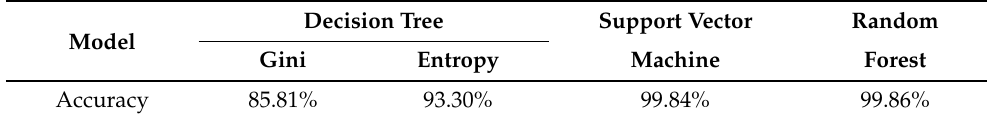
Table 3. An example to show the prediction accuracies of the three ML models. Decision Tree Support Vector Random Model Gini Entropy Machine Forest Accuracy 85.81% Ground